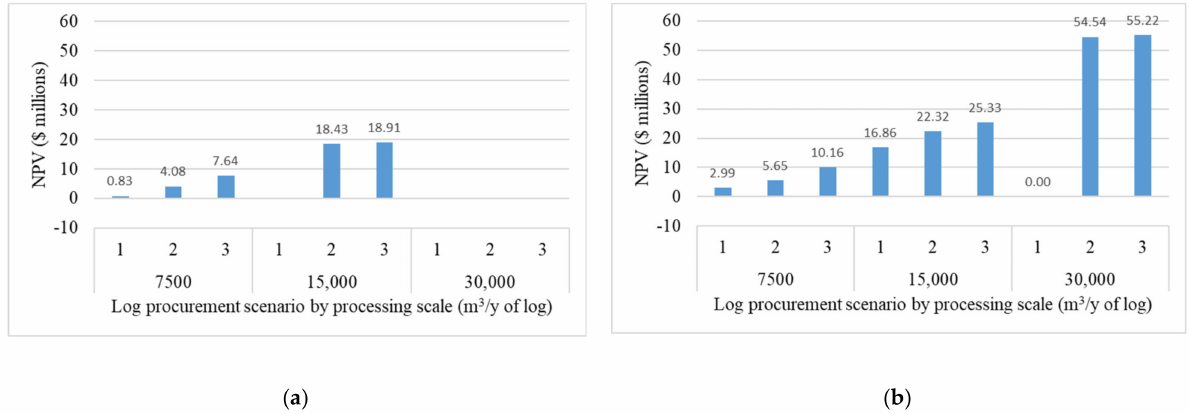
Figure 3. NPV for integrated production of two-stage LVL. ( a ) Facility location A. ( b ) Facility location